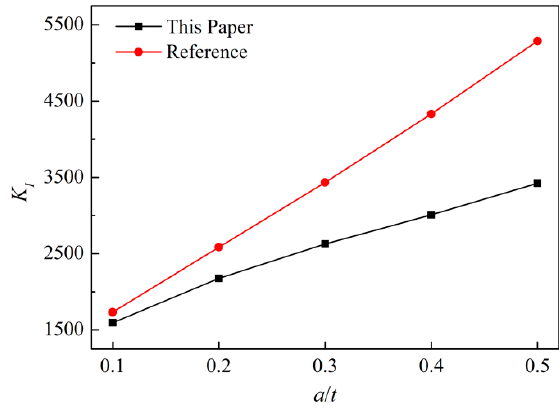
Figure 7. Comparison of two SIFs. Table 2. Parameters of finite element model. Parameter Cracks of Interface Reference [33] Inner diameter of internal